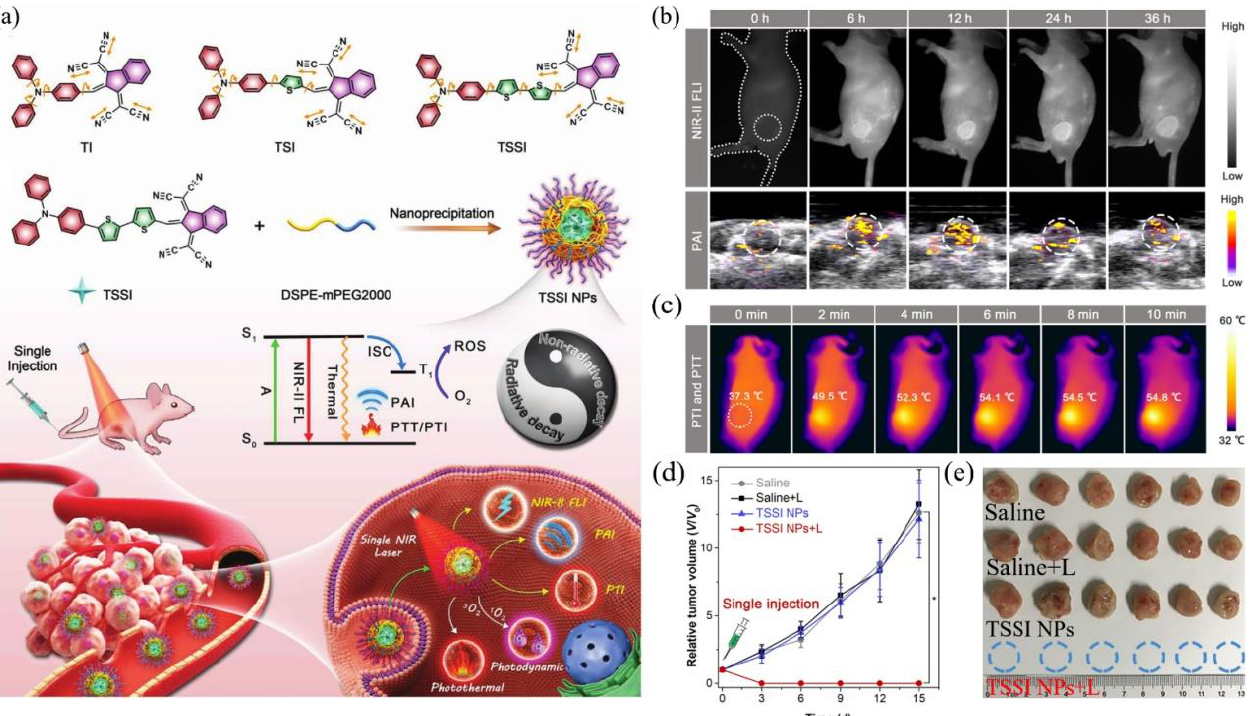
Figure 6. ( a ) Diagram of all-around AIE molecular structures, nanoparticles fabricating, and multi- modal phototheranostic system; ( b ) NIR-II FLI (upper) and PAI (lower) for tumor-bearing mice from 0 h to 36 h postinjection of TSSI NPs; ( c ) PTI and PTT for tumor-bearing mice at 12 h postinjec- tion of TSSI NPs upon laser irradiation; ( d ) tumor growth curves of mice with various treatments; ( e ) photograph of 4T1 tumors harvested from the mice at day 15 after different treatment. Reprinted with permission from Ref. [83]. Copyright 2020, Wiley-VCH.